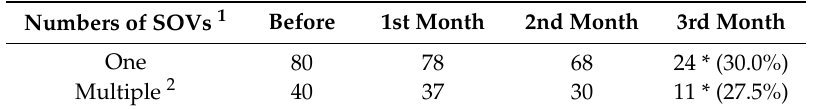
Table 1. Change in various floaters before and after taking the fruit enzymes over a 3-month treatment. All 120 patients all took the capsule twice daily. The capsule of fruit enzymes included 190 mg bromelain, 95 mg papain and 95 mg